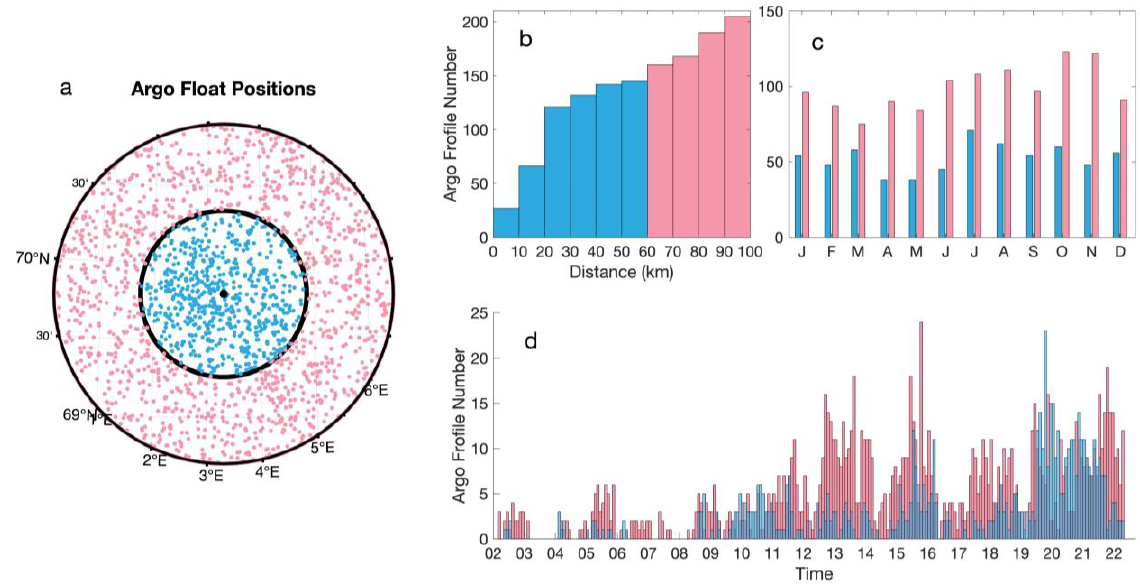
Figure 2. Spatial–temporal distribution of the Argo profiles of areas around the CLV from Jan. 2002 to Mar. 2022. ( a ) Position of Argo floats. ( b ) Argo profile numbers with increasing distance from the CCLV. ( c ) Seasonal quantity distribution and ( d ) monthly quantity distribution of the Argo profiles from Jan. 2002 to Mar. 2022. The blue dots or bins are the Argo positions or numbers within the CLV with a radius of 60 km, and the pink dots or bins are the Argo positions or numbers within a cyclic ring with a radius of 60–120